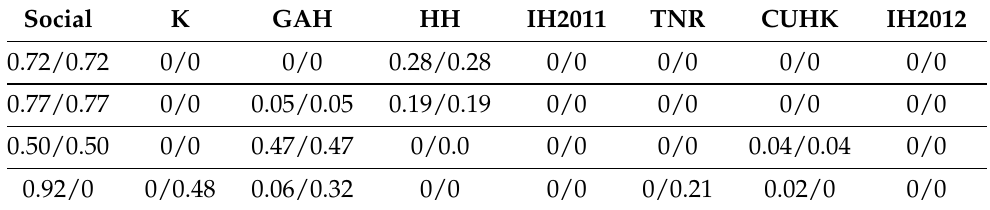
Table 6. Mixed Nash equilibrium for the dynamic agent society. Each row represents a different mixed equilibrium. In each cell, the first number represents the ratio of use of the strategy for the first player, while the second represents the ratio of use of the same strategy for the second